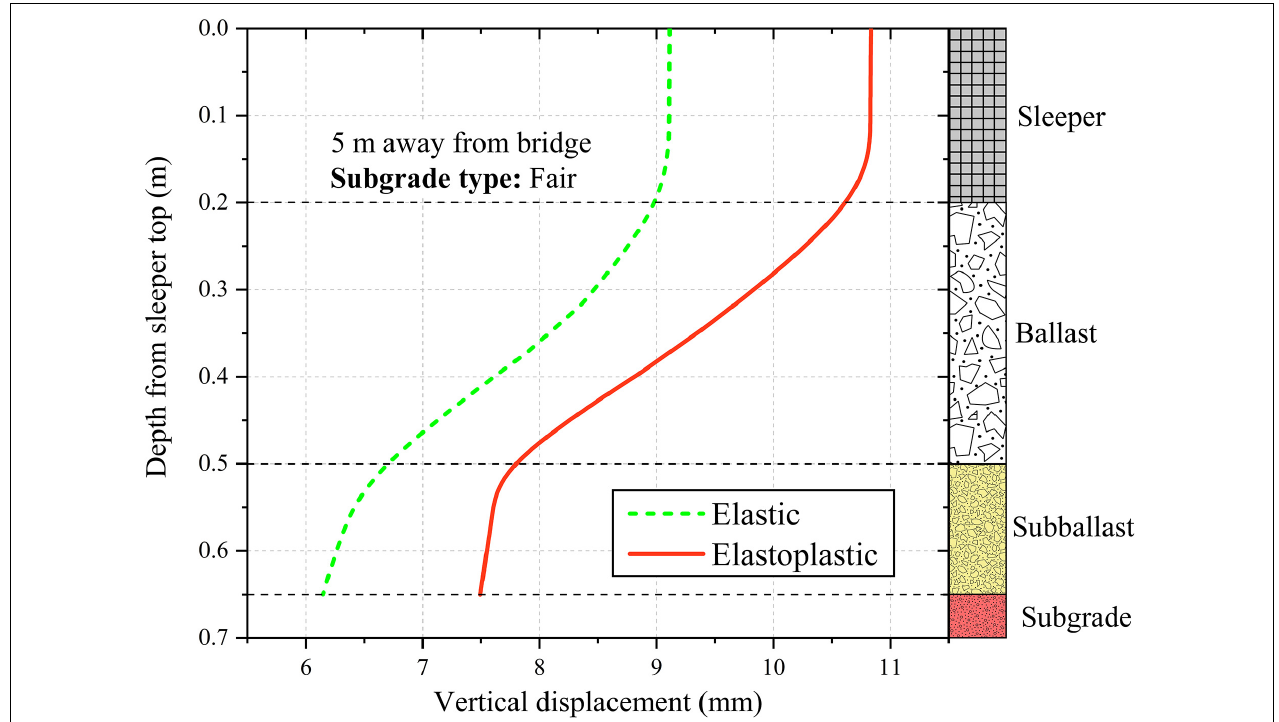
FIGURE 7 | Variation of vertical displacement with depth predicted using elastic and elastoplastic material models for subgrade, at 5 m away from the bridge.